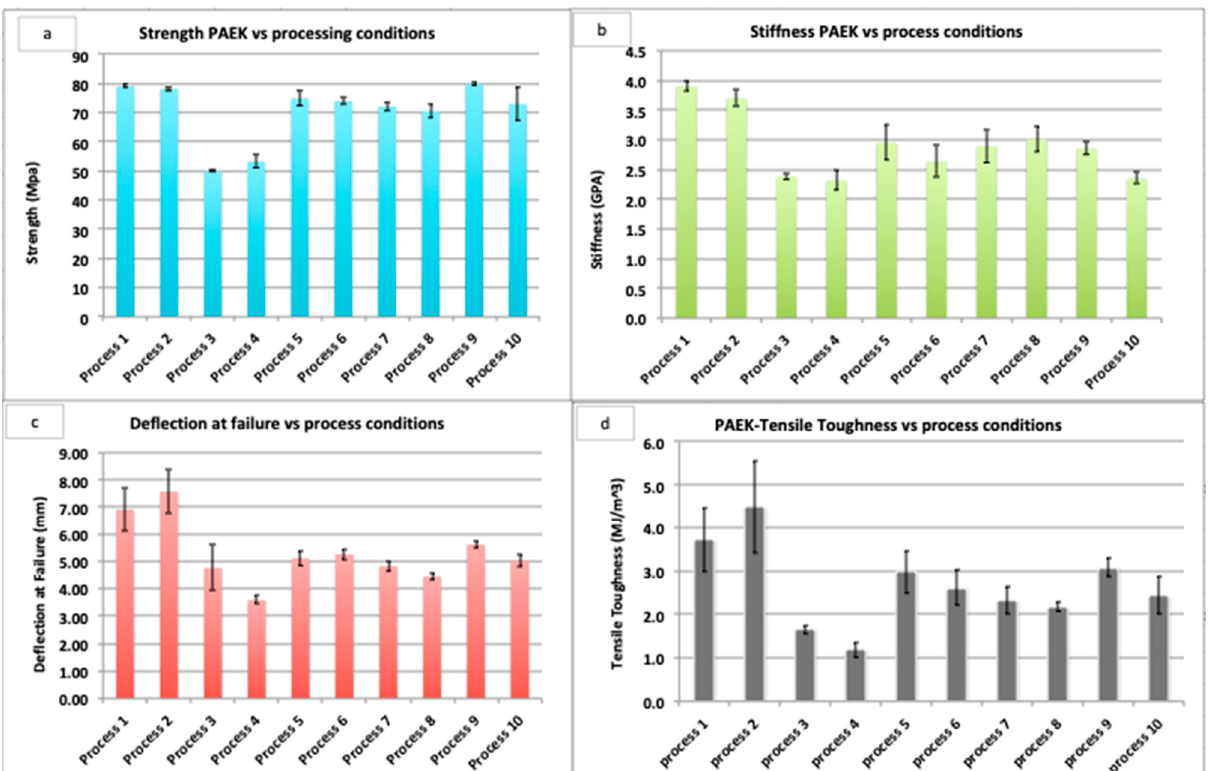
Figure 8. Measured ( a ) strength, ( b ) sti ff ness, ( c ) de fl ection at failure, and ( d ) toughness, with standard deviations. The X-axis label refers to the di ff erent process conditions, as listed in Table 2. The PEAK coupons fabricated at 450 °C show li tt le e ff ect due to change in raster angle (80 ± 1.2(cid:4667) MPa. The strength of PAEK polymer parts changes signi fi cantly with change in